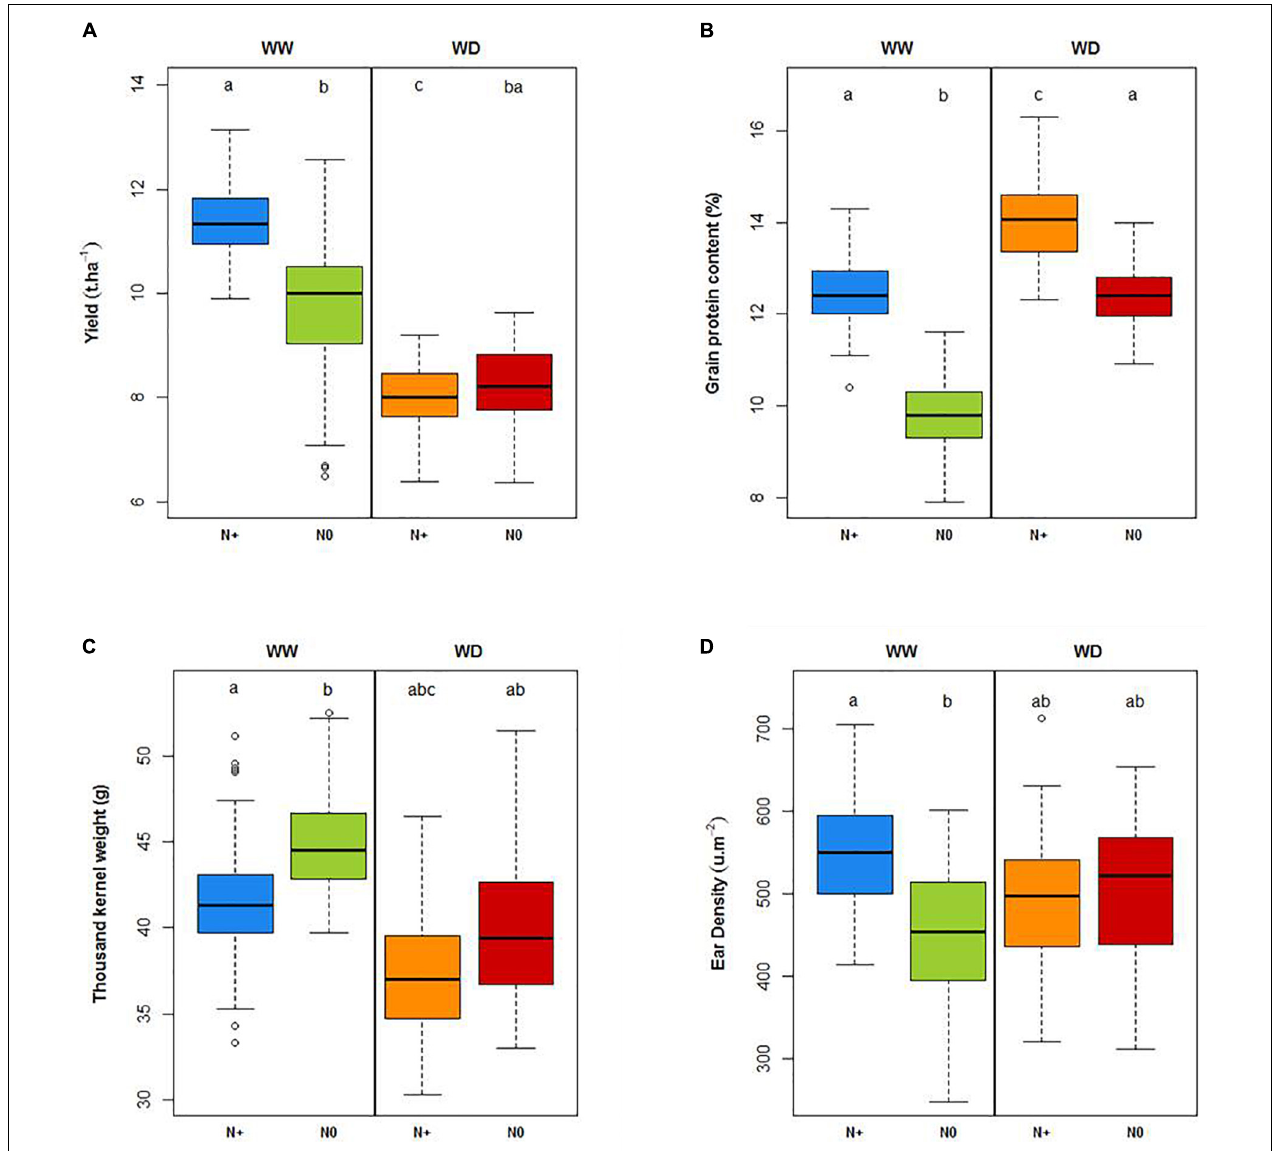
FIGURE 10 | Yield (t.ha − 1 ; A ), grain protein content (%; B ), thousand kernel weight (g, C ) and ear density ( µ .m − 2 ; D ) under well-watered (WW) and water deficient (WD) conditions with and without nitrogen (N+, N0). Letters represent significant differences (Tukey post hoc test, p <